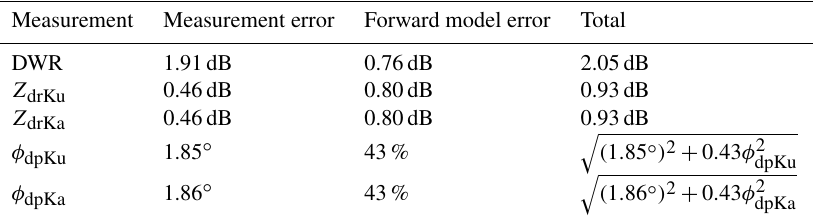
Table 6. Measurement and forward model components of the error covariance matrix S y for each measurement, expressed as standard